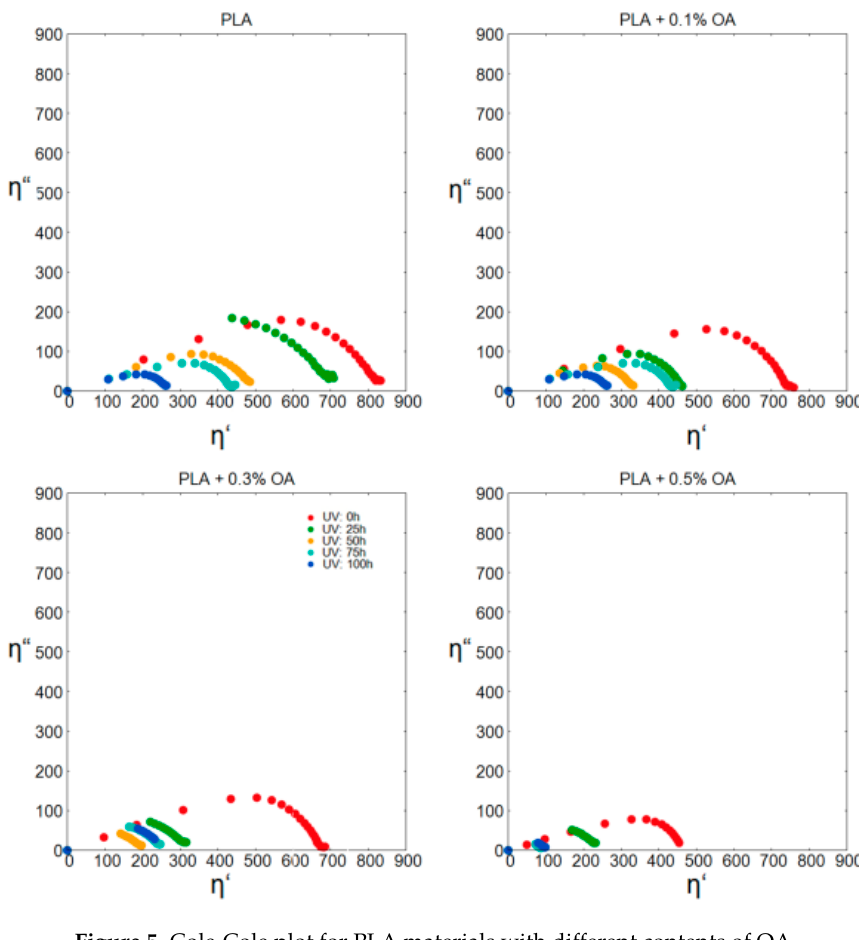
Figure 5. Cole-Cole plot for PLA materials with different contents of OA.